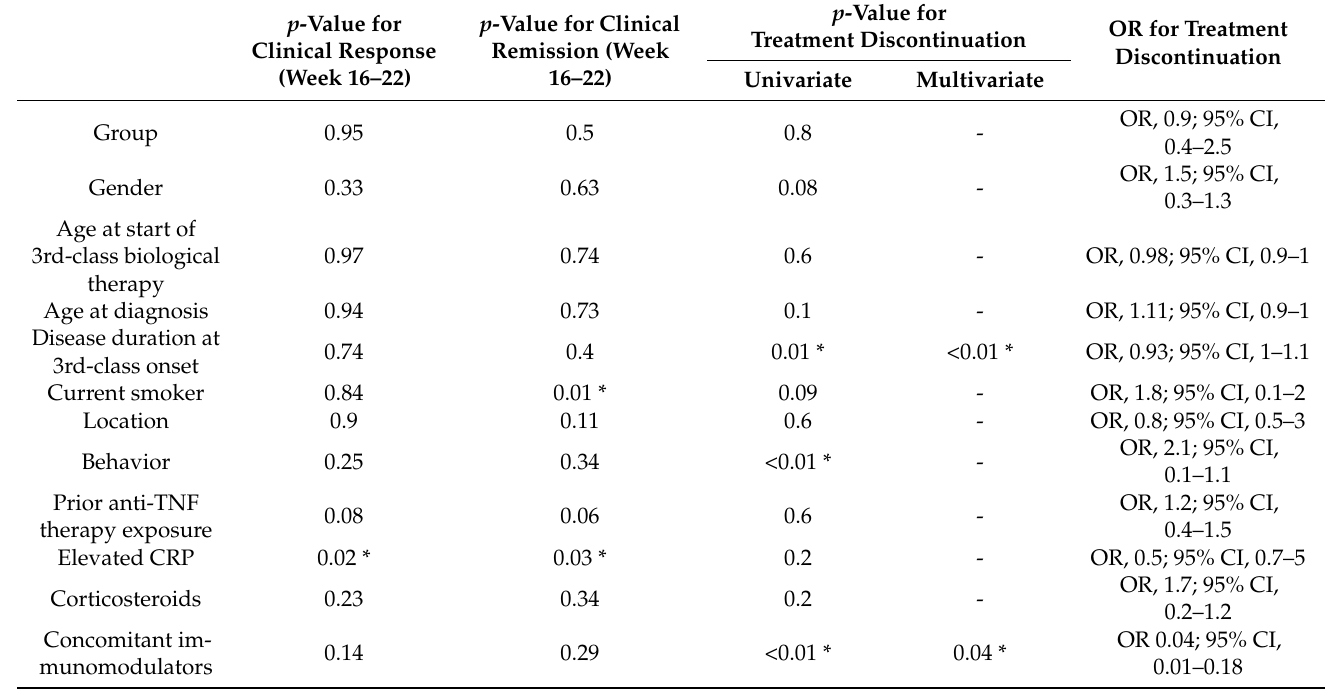
Table 2. Clinical variables associated with clinical response, remission, and treatment discontinuation. p -Value